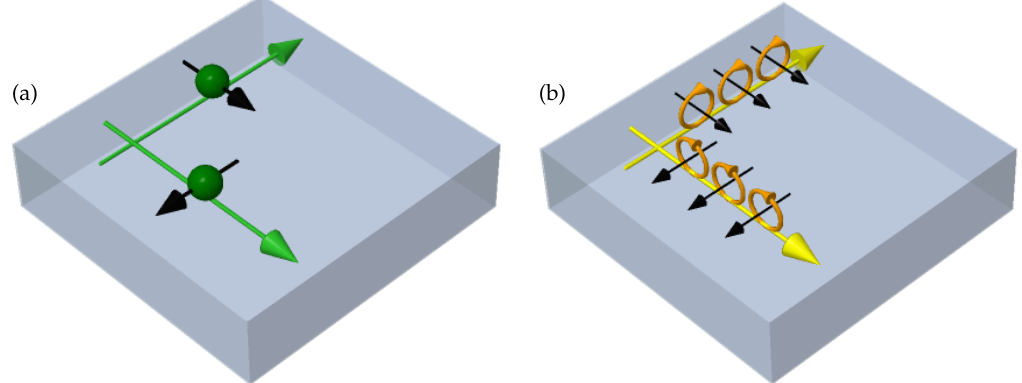
Figure 8. Conceptual diagrams of ( a ) electronic helical surface states and ( b ) photonic helical surface